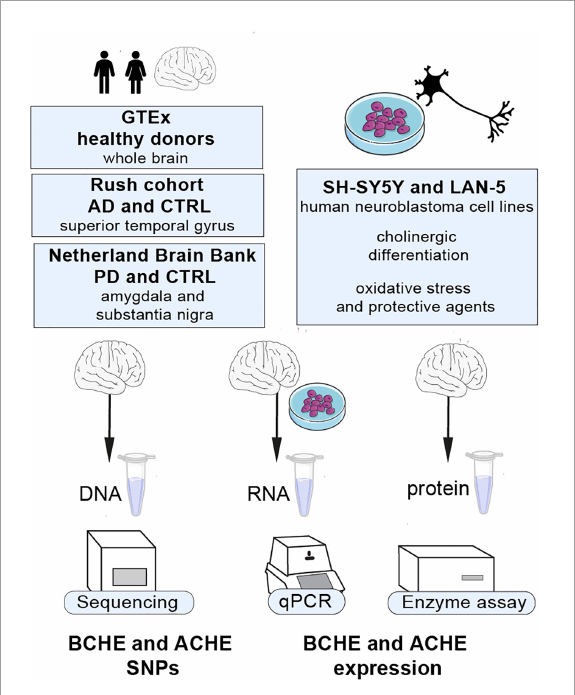
FIGURE1 Our study’s outline. Cholinergic transcripts were analyzed by qPCR, Sanger sequencing, and enzyme activity assays from different regions of human post-mortem brains from AD and PD patients, SH-SY5Y and LAN-5 cells, and GTEx cohort